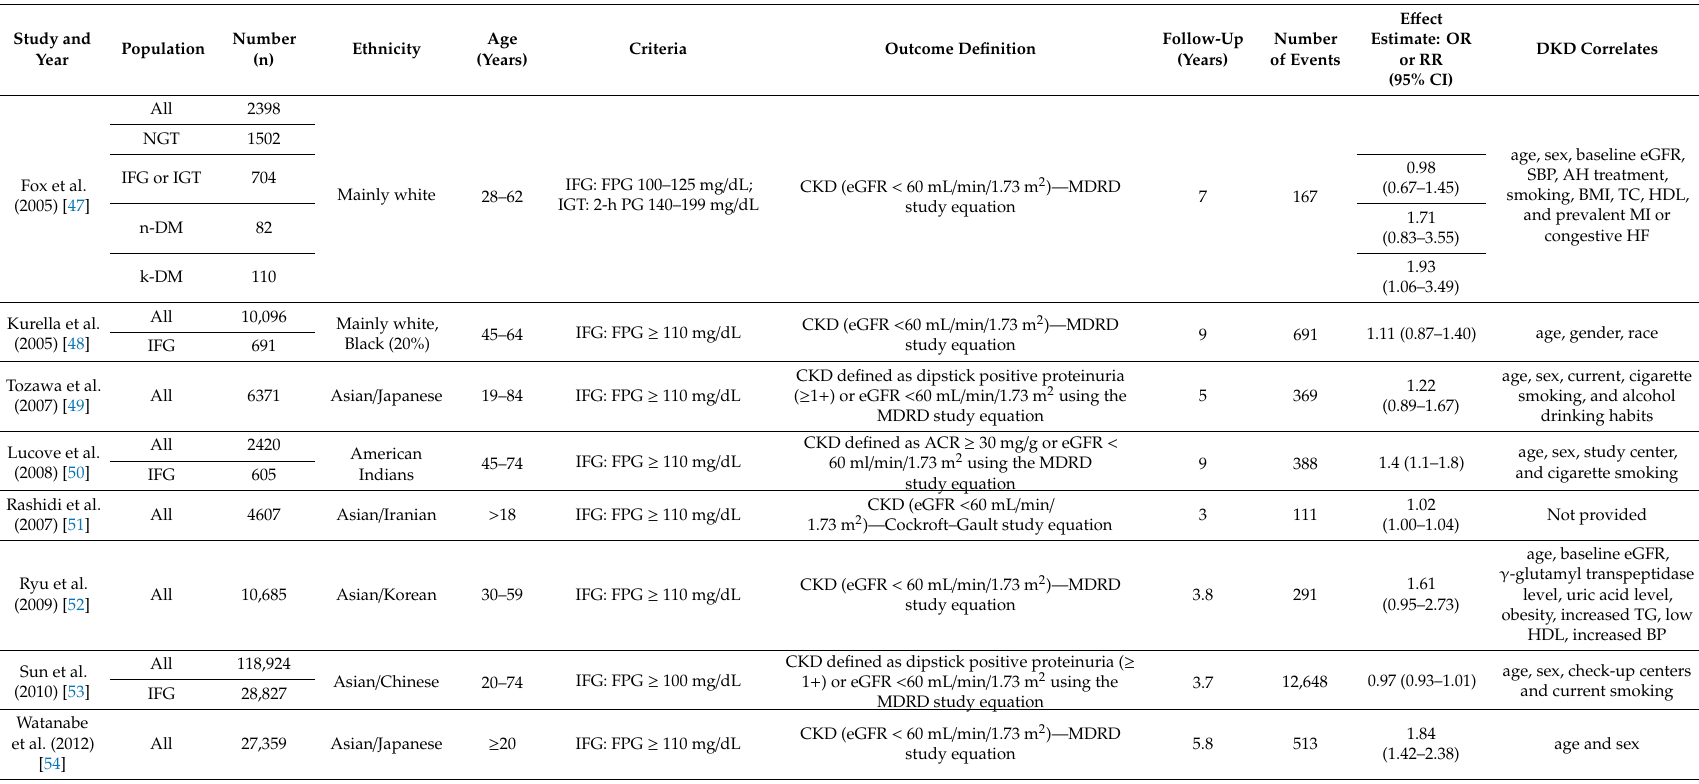
Table 2. Characteristics of cohort studies on the association between prediabetes and risk of chronic kidney